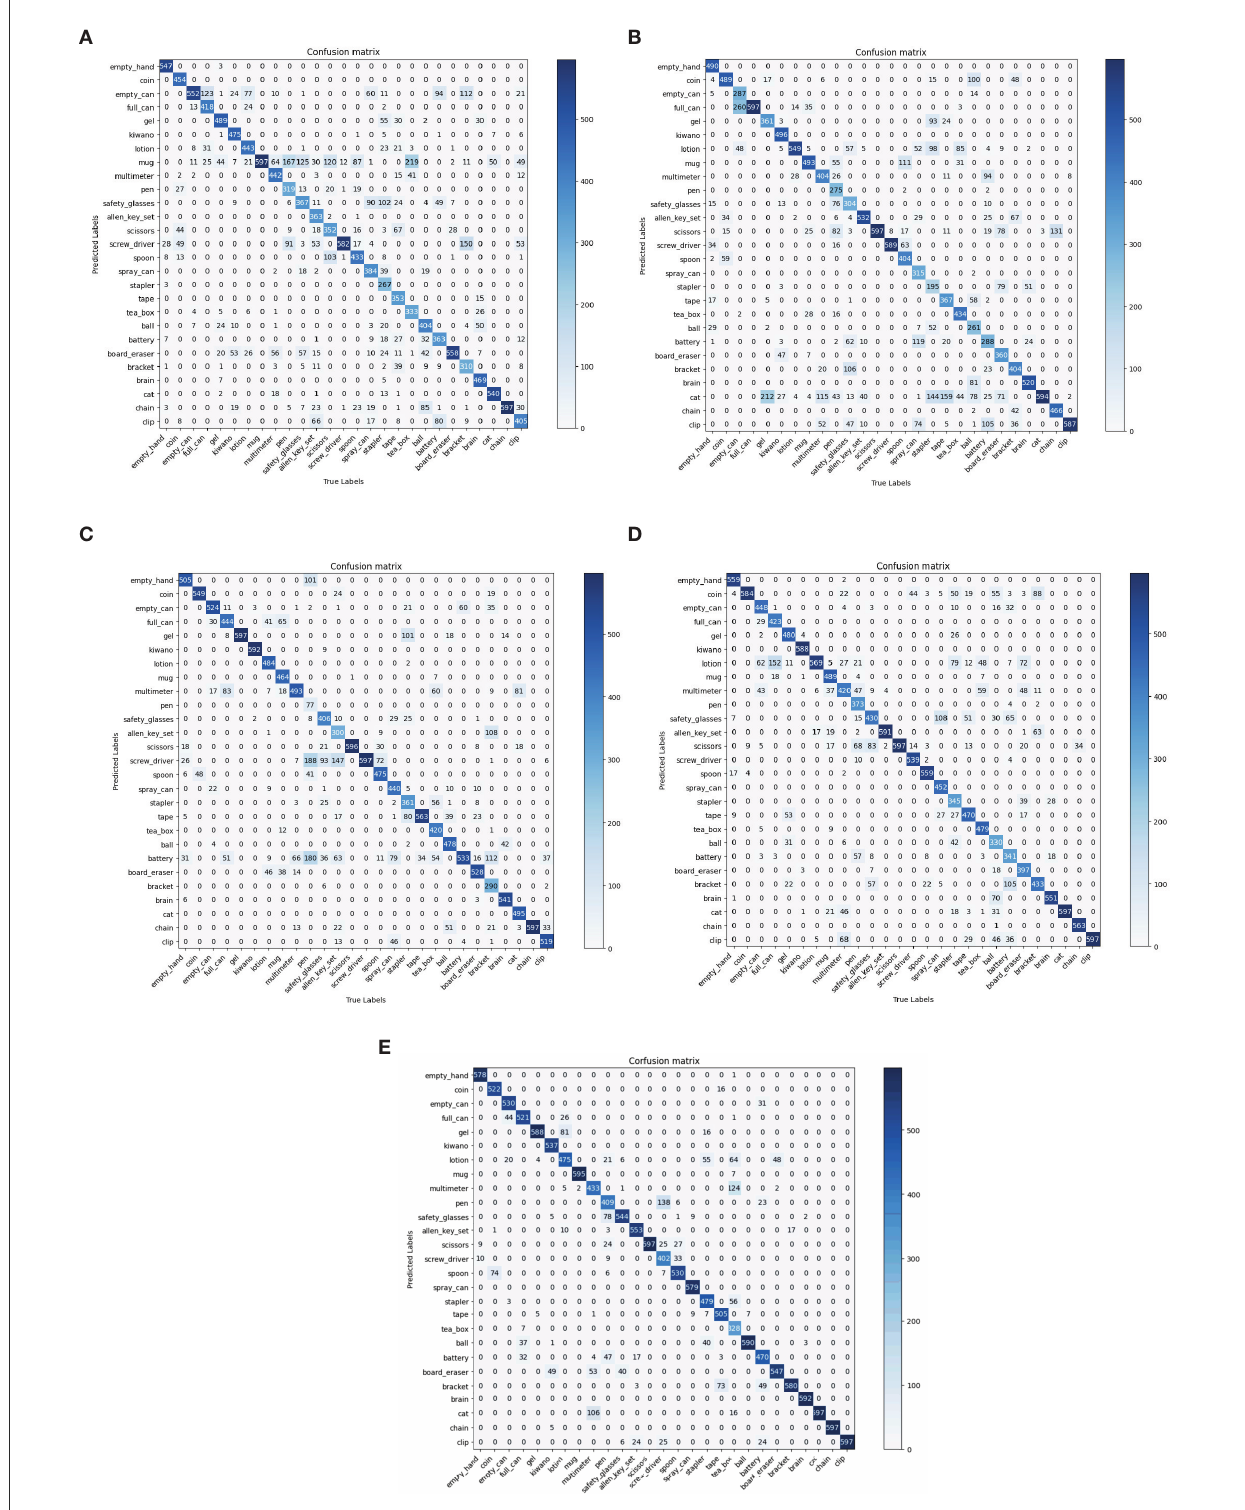
FIGURE4 Comparisons with state-of-the-art models in terms of confusion matrix on the MIT-STAG dataset. (A) Sundaram et al., 2019, (B) Wang et al., 2021, (C) Zhang et al., 2021, (D) Sharma, 2022, (E)